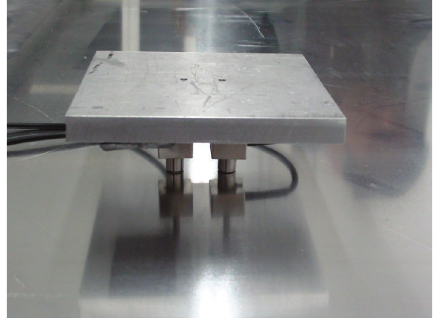
Figure 5: The designed handmade transducer